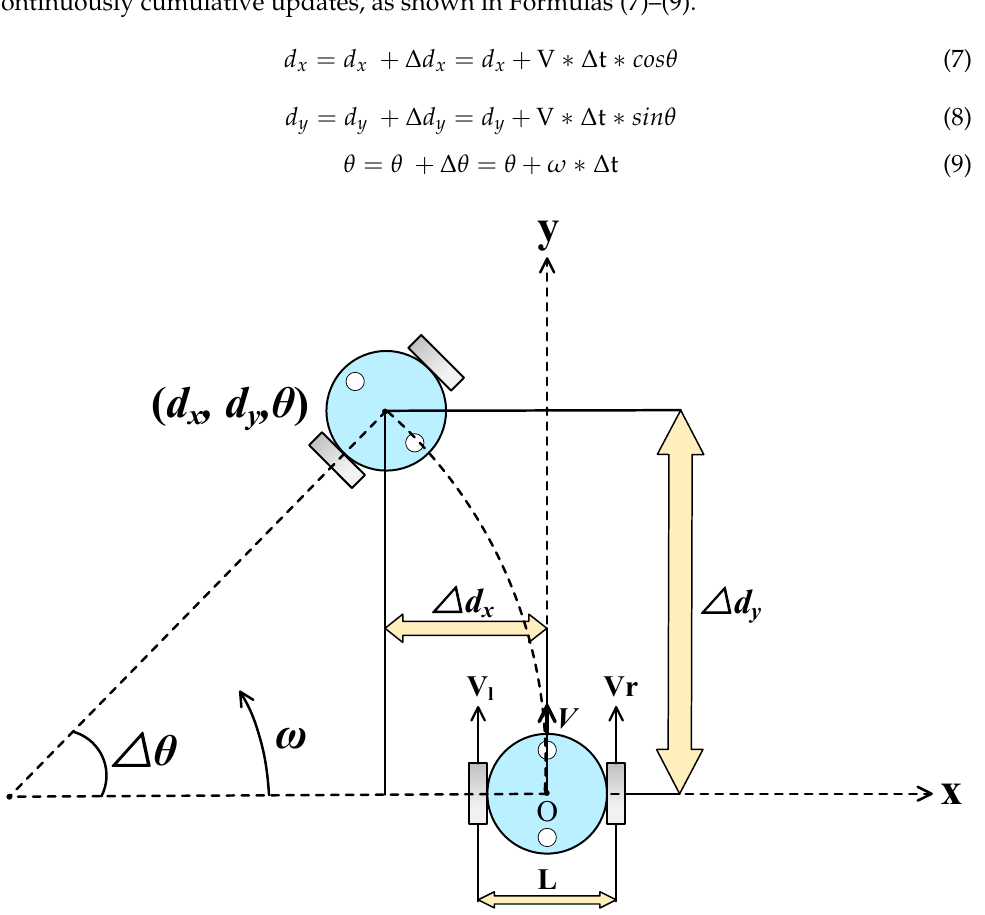
Figure 2. The kinematic model of the two-wheel differential robot.